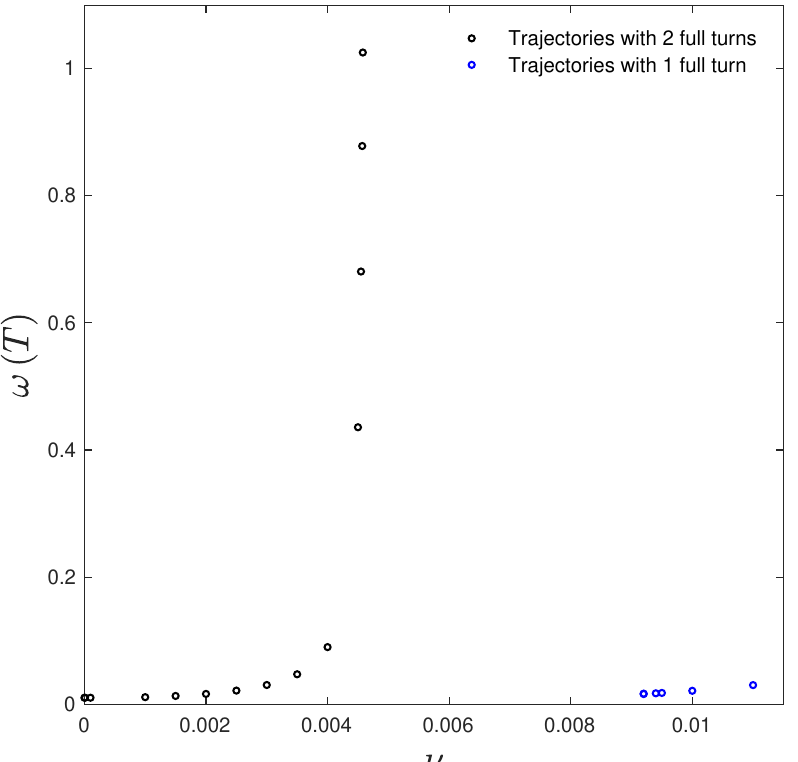
Figure 6. Energy cost for the problem with parameters ρ 0 = 2 k = 1 m 2 s − 1 and different kinematic viscosities for the flow. The cost increases with viscosity for solutions of the same nature (i.e., the number of full turns of the particle around the vortex), but there is a sharp decrease in energy when the nature of the solution changes to a smaller number of complete